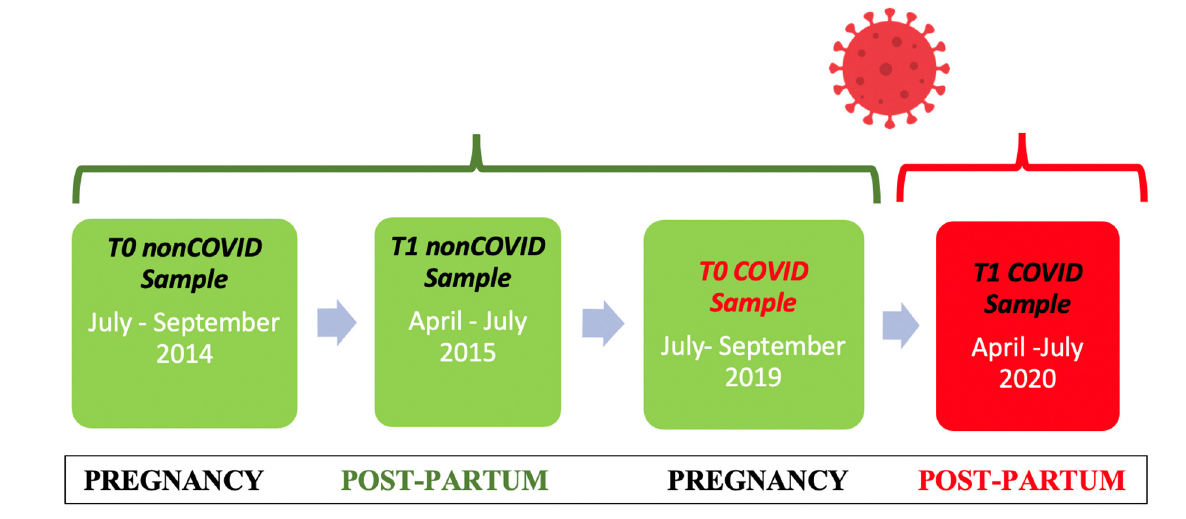
Figure 1. Design of the study. Table 1. Socio-demographic and clinical characteristics of the COVID (N = 72) and Non-COVID (N = 68) samples ( p values reflect Student’s t for means and SDs, and χ 2 for N and